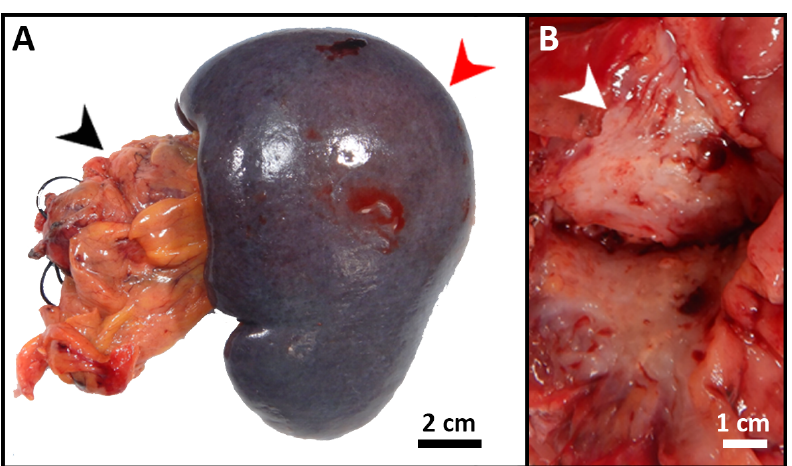
Figure 3. Gross images of the resected pancreatic tumor. ( A ) Segment of distal pancreas (black arrow) with attached spleen (red arrow) and attached hilar adipose tissue. ( B ) Cut section through the tail of pancreas revealed a 3 cm firm mass (white arrow) with a white-to-yellow indurated cut sur- face.